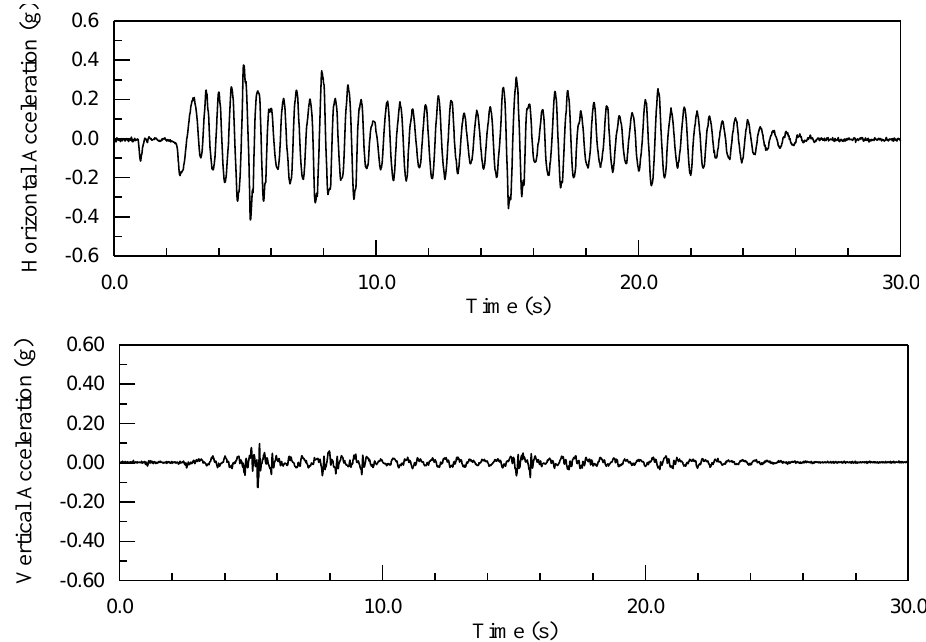
Figure 7. Input horizontal and vertical acceleration – time histories at the base of the model.